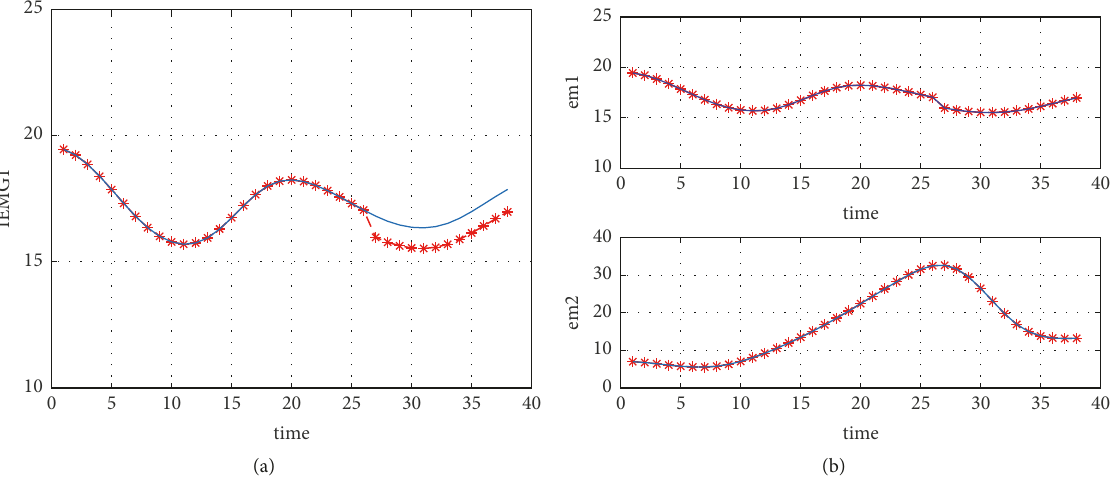
Figure 7: Decrease of the amplitude fault in IEMG signal. (a) Healthy and faulty IEMG signal. (b) Real and estimated faulty input.